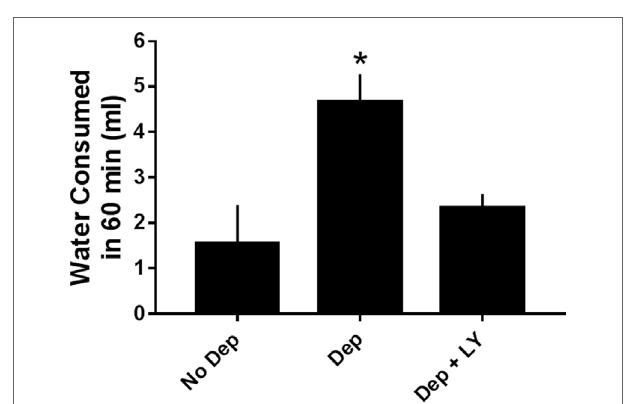
FigUre 7 | effects of cPD1 on deprivation-induced drinking . Water deprivation significantly increased the amount of water consumed and this enhancement was prevented by CPD 1 ( F 2,18 = 7.5, p < 0.01). Data are means ± SEM of 6–8 rats/group. * p < 0.05 compared to vehicle (Dunnett’s test).